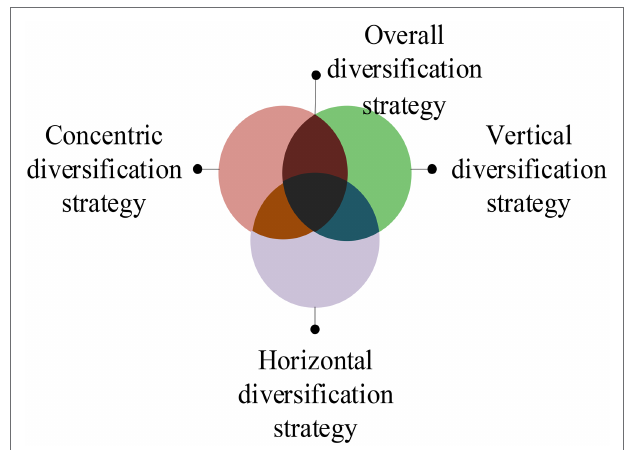
FIGURE 2 | Types of enterprise